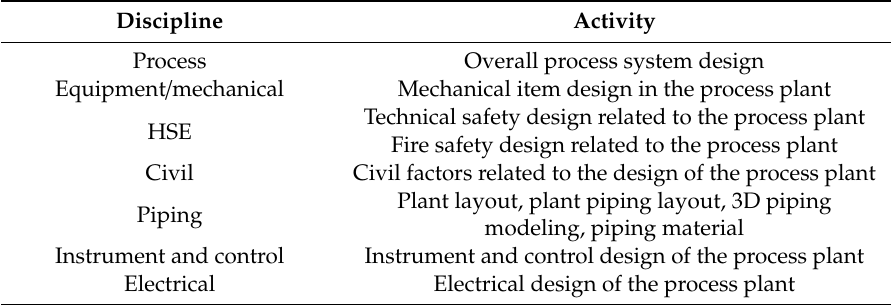
Table 1. Major disciplines of engineering in the process-plant industry.